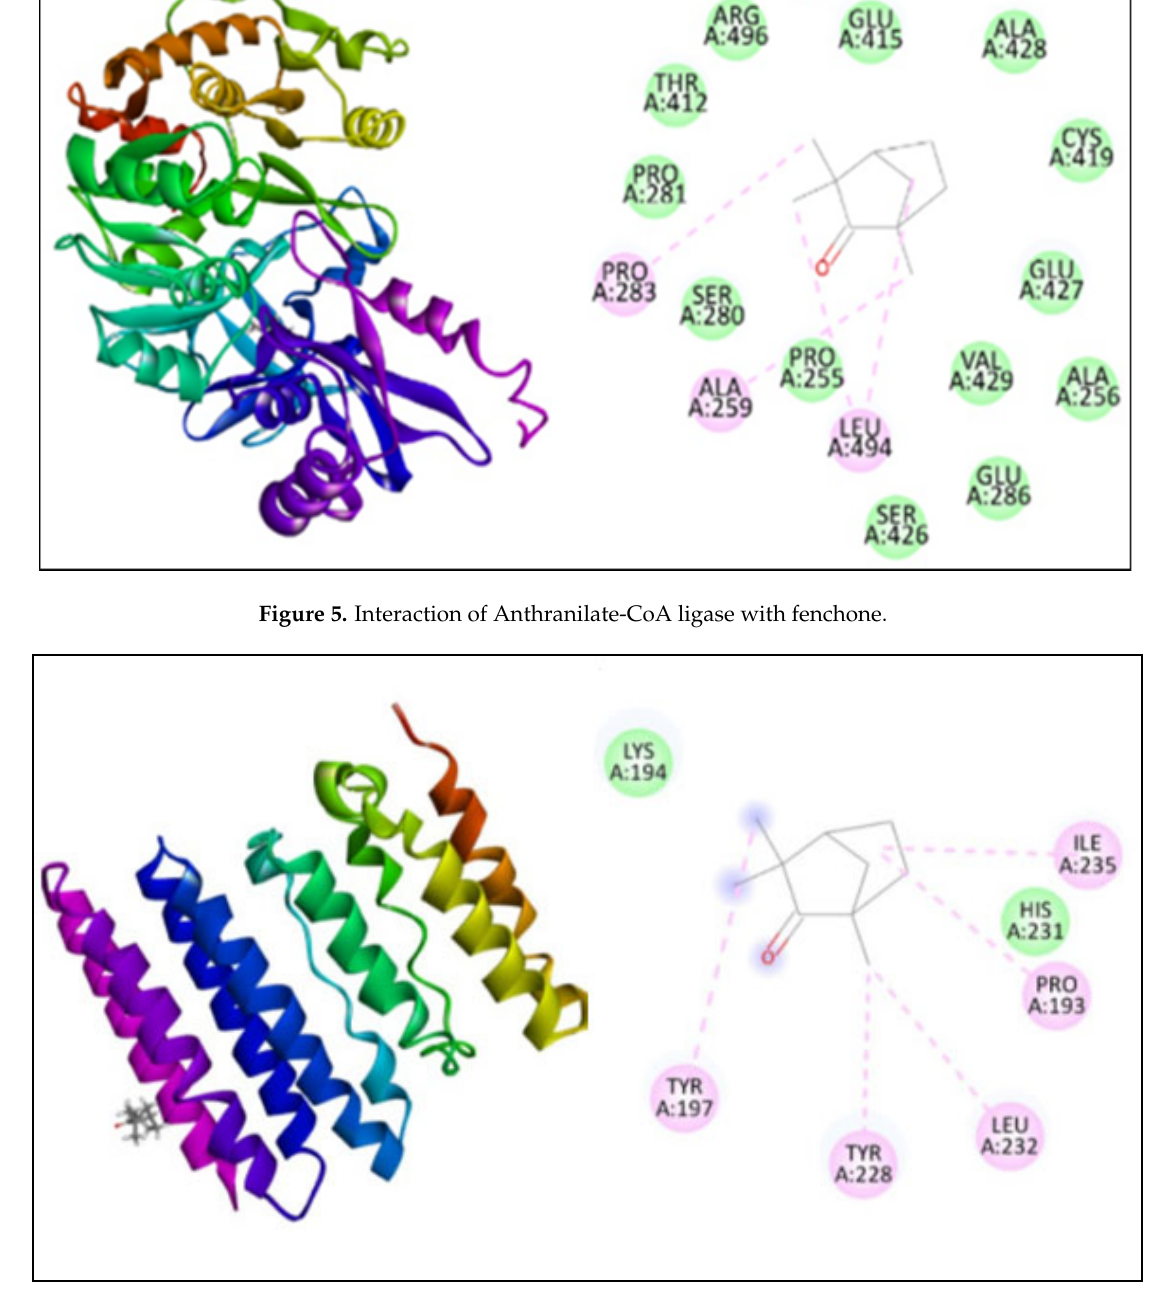
Figure 6. Interaction of 1, 3 ‐β –D ‐ glucan synthase with fenchone.